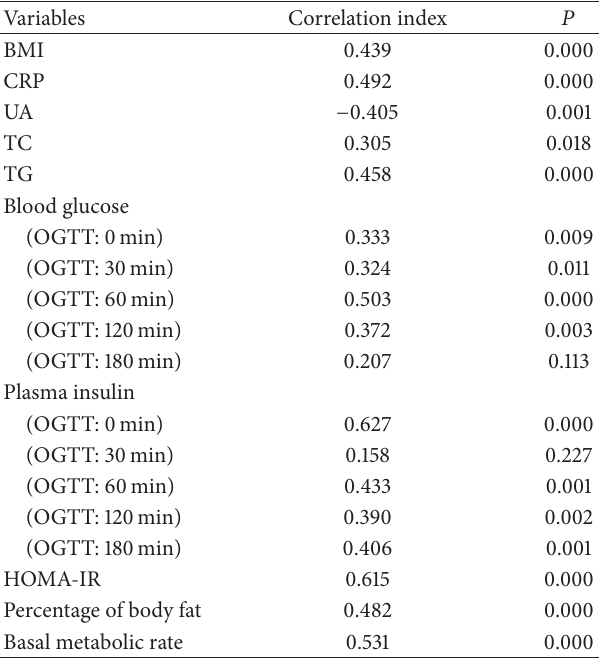
Table 2: Correlation analysis of FGF21 in whole cohort ( 𝑛 = 120 ). Table 3: Correlation analysis of FGF21 in OB ( 𝑛 = 40 ) and AN groups ( 𝑛 = 40